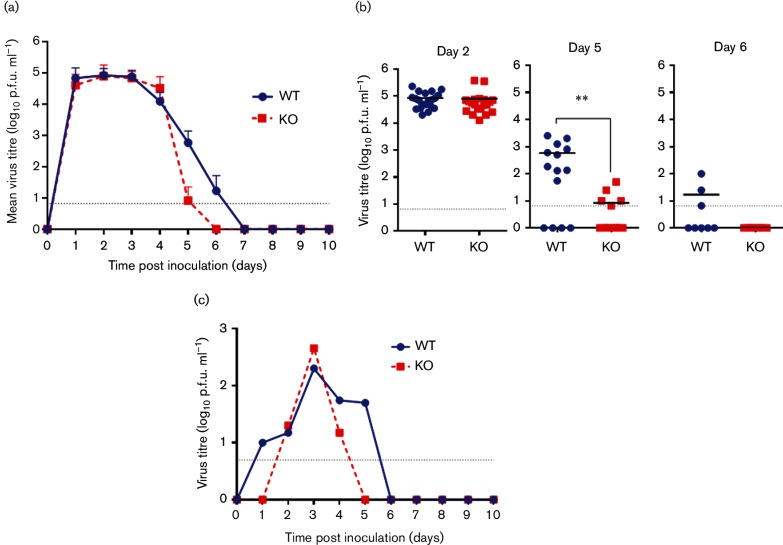
Virus shedding from the buccal cavity of high-dose-inoculated chickens and environmental viral titres. Infectious virus from groups of 20 chickens inoculated with 1×105 p.f.u. (high dose) with either WT (blue circles) or KO (red squares) UDL01 influenza virus. Grey dotted baselines indicate limit of detection. (a) Mean infectious virus titres from buccal swabs. (b) Buccal shedding titres from individual birds at 2, 5 and 6 days post inoculation. (c) Infectious virus titres in communal drinking water. A pooled sample from the water sources in each isolator was assessed daily. Means±sd are shown where applicable. Levels of significance were based upon P-values from a Mann–Whitney U-test; **P<0.001.